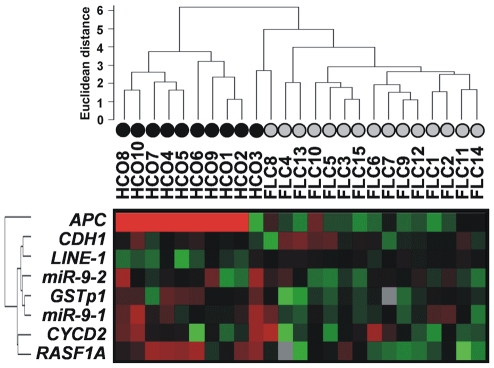
Cluster analysis of methylation data for FLC and common HCC without cirrhosis.The quantitative methylation data were log-transformed and translated into a color code.